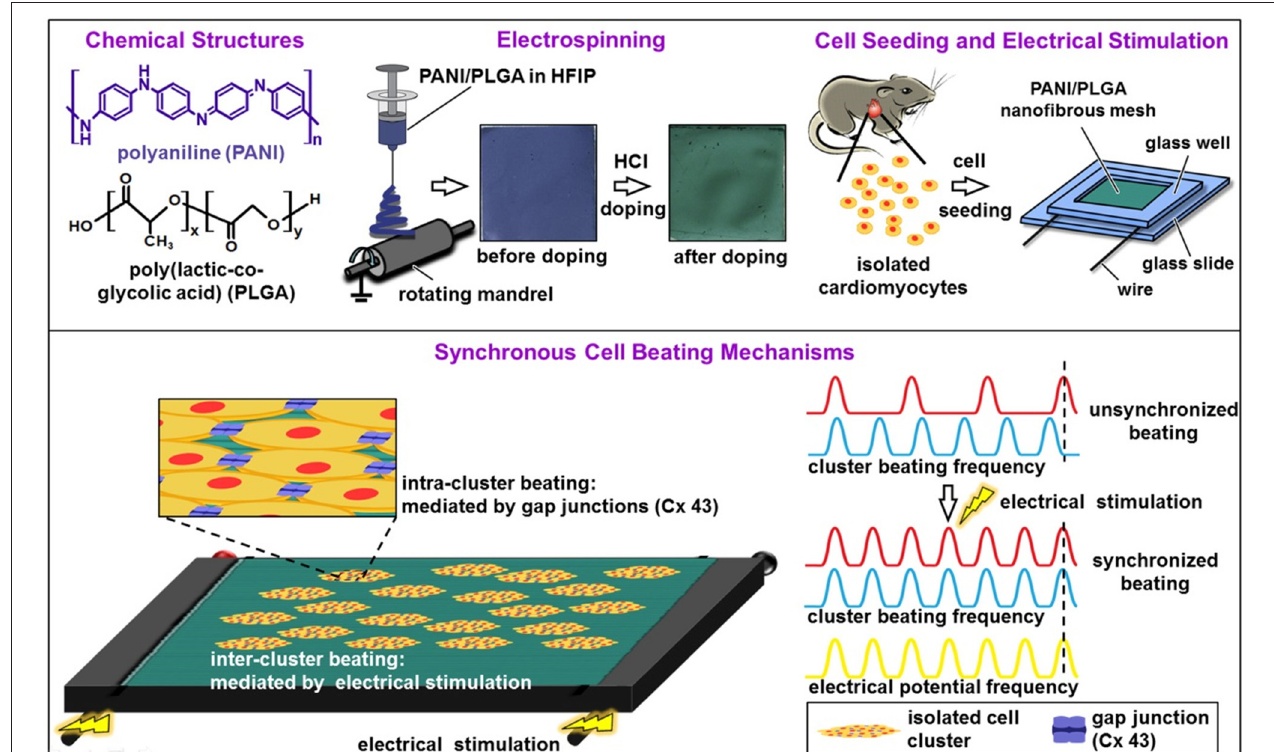
FIGURE 5 | Diagrams showing the fabrication of aligned conductive PANI/PLGA nanofibrous mesh, cell seeding, ES, and the mechanisms involved in the synchronous cell beatings. Adapted from ( 80) with permission from the publisher.